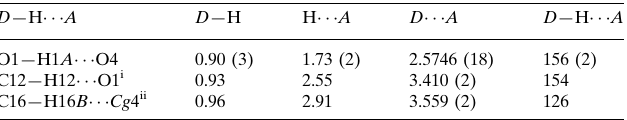
Hydrogen-bond geometry (A˚ , (cid:2)